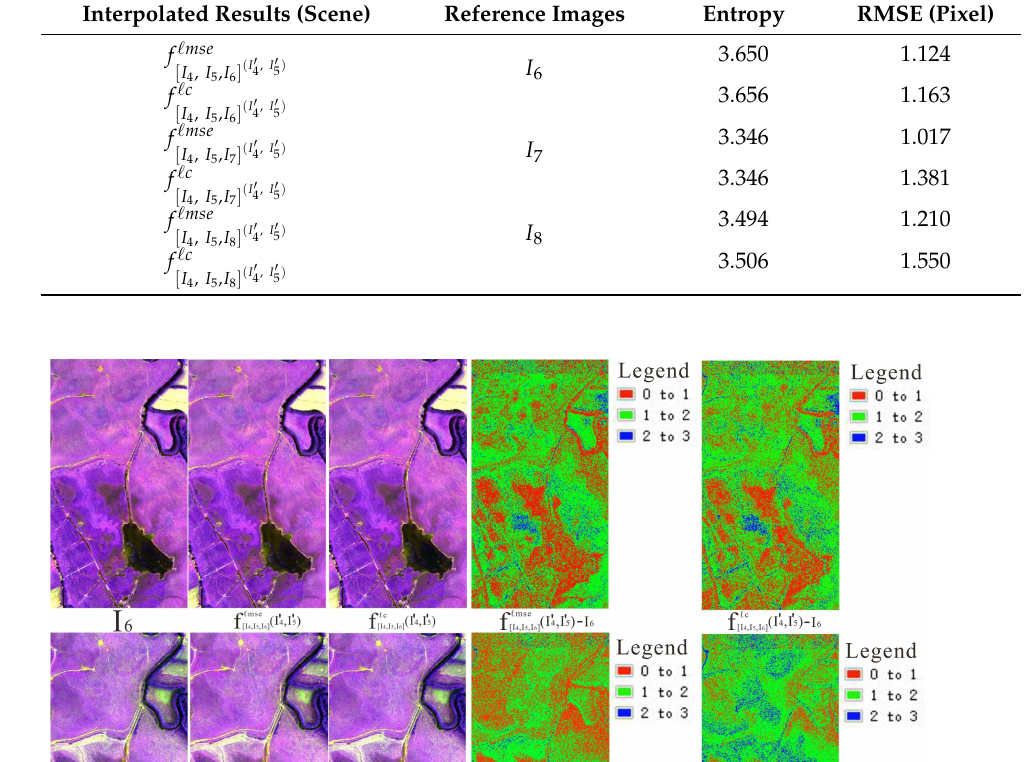
Table 5. Quantitative evaluation between scene interpolated result and reference scene image.